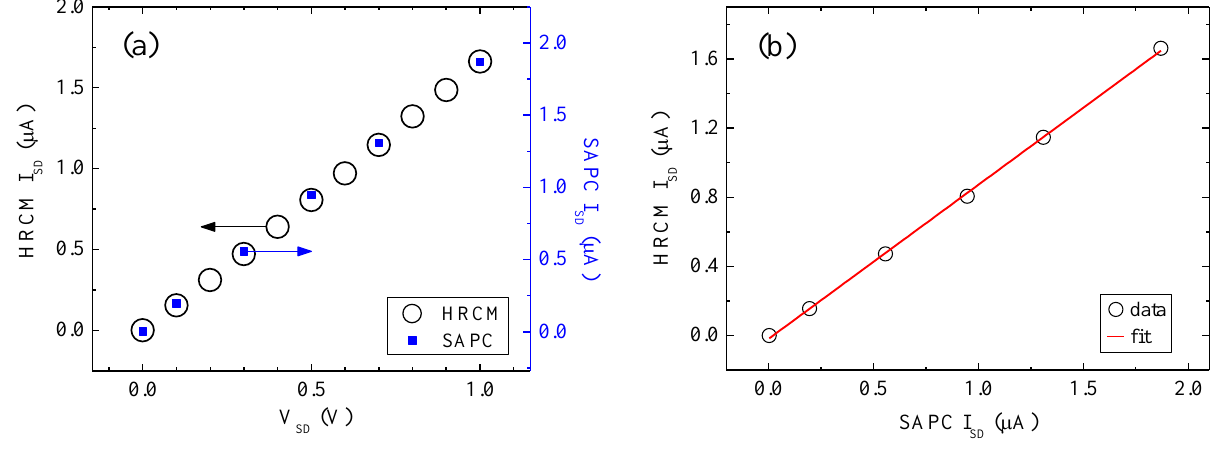
Figure 5. ( a ) I -V measurement of the CNT sensors by high resolution current meter SD SD (HRCM) and the SAPC and ( b ) calibration graph of I from